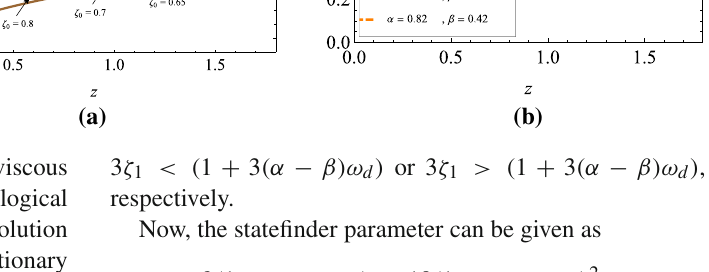
Fig. 5 a The Om(z) evolutionary diagram of viscous NHDE for different values of ζ > 0 with fixed ω = − 0 . 5, d 0 α = 0 . 8502 and β = 0 . 4817. b The Om(z) evolutionary diagram of viscous NHDE for different values of α and β with fixed ζ = 0 . 02 with ω = − 0 . d 0